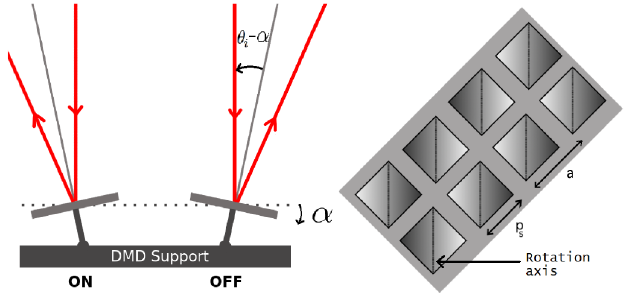
Fig. 1. Operating principle of the DMD. On the left, the two ON and OFF modes of a micromirror. Each micromirror rotates on its diagonal therefore the DMD is rotated at 45 ◦ in order to keep the incident beam parallel to the